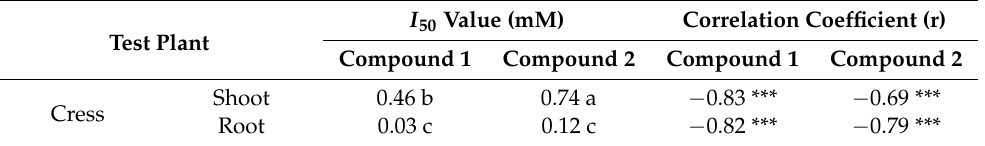
Table 3. I 50 values (mM) and the correlation coefficient (r) of the shoot and root growth of cress by compound 1 and compound 2 .